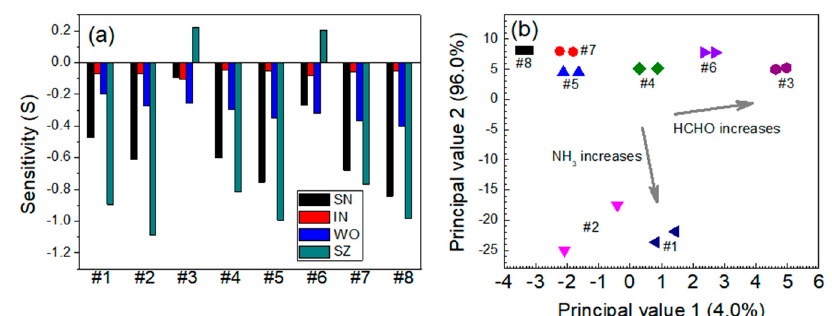
Figure 11. ( a ) Responses of the sensors and ( b ) PCA-based dual-gas sensor monitoring for the NH 3 -HCHO system. Note that #1–#8 represent 5 ppm NH 3 + 0 ppm HCHO, 10 ppm NH 3 + 0 ppm HCHO, 0 ppm NH 3 + 2.5 ppm HCHO, 5 ppm NH 3 + 2.5 ppm HCHO, 10 ppm NH 3 + 2.5 ppm HCHO, 0 ppm NH 3 + 5 ppm HCHO, 5 ppm NH 3 + 5 ppm HCHO, and 10 ppm NH 3 + 5 ppm HCHO, respectively.